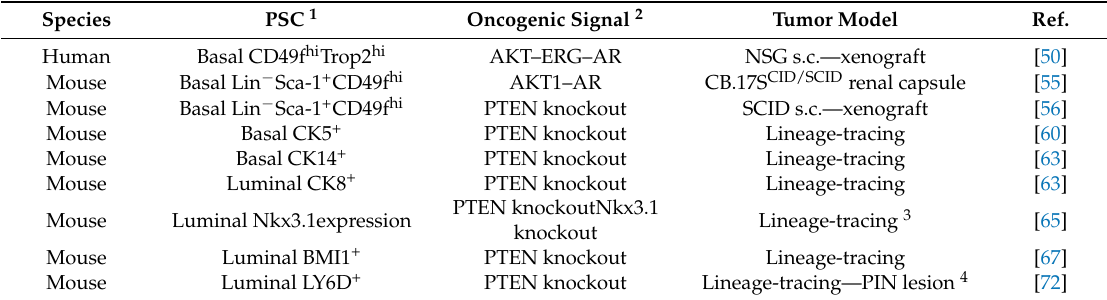
Table 1. PSCs are able to initiate